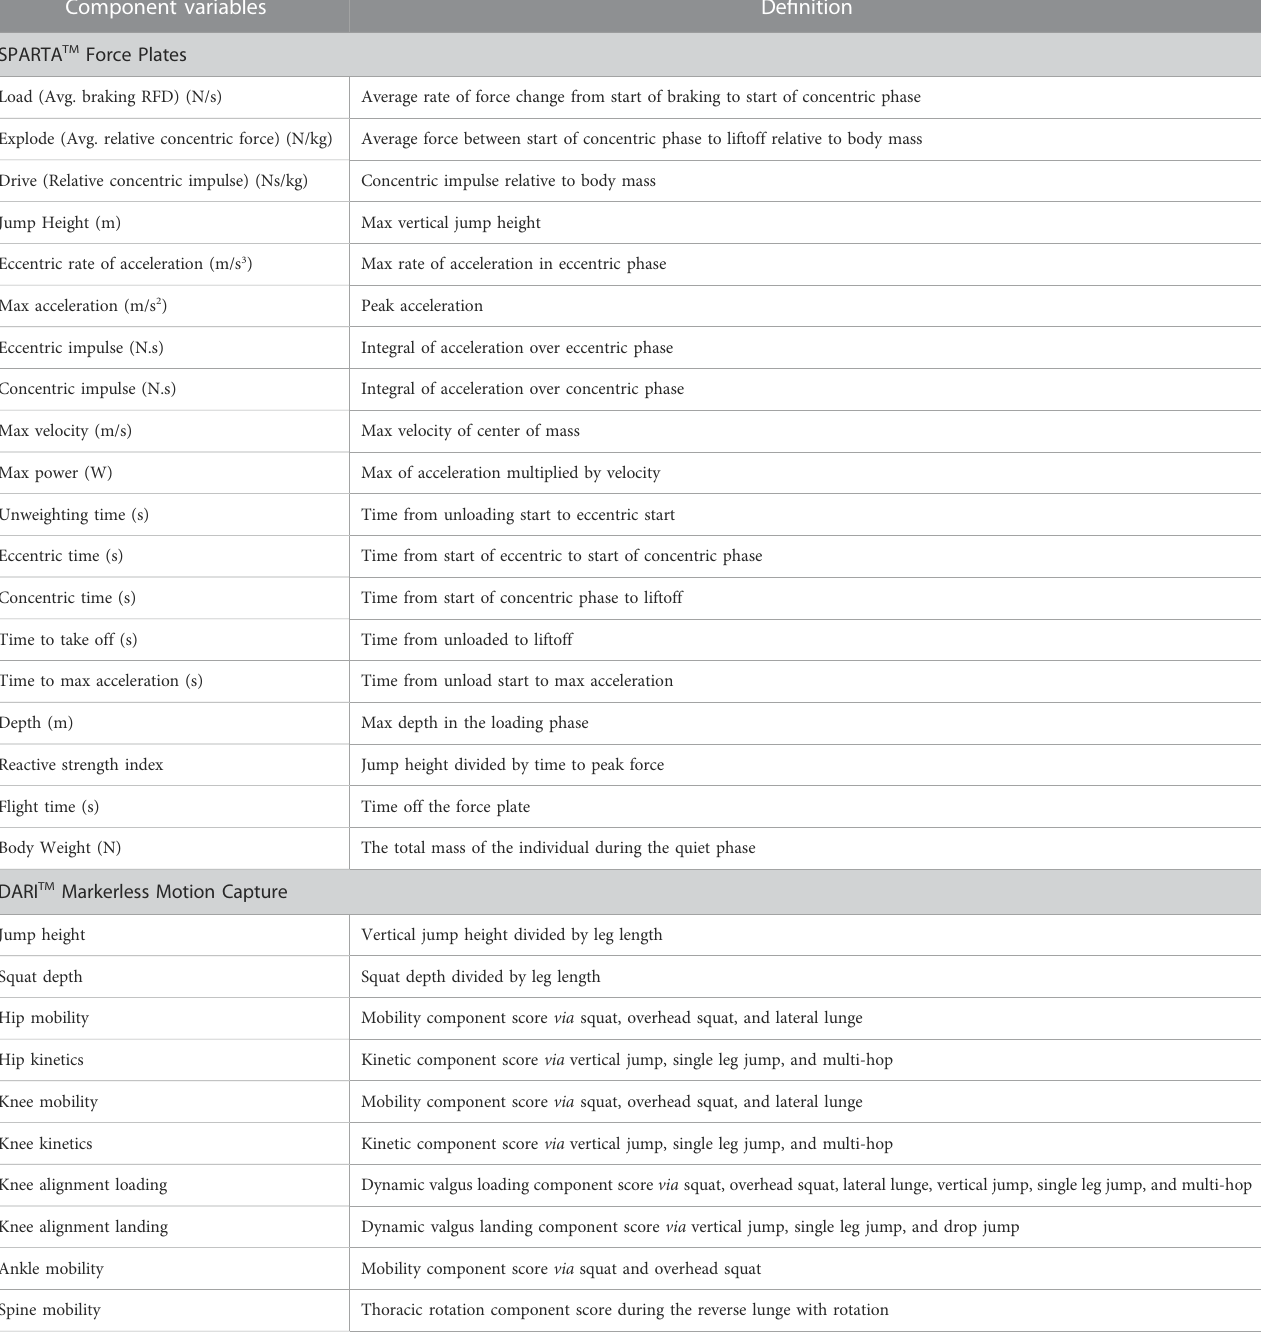
TABLE 2 De fi nitions of SPARTA ™ and DARI ™ component variables. Component